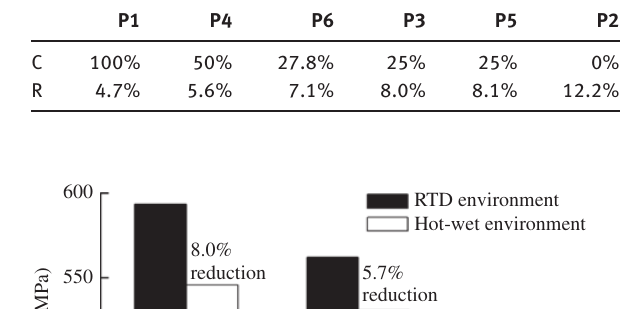
Figure 4: Tensile strength of the specimens with Z-pins. (A) Tensile strength of the unidirectional tape specimens with Z-pins. (B) Tensile strength of the woven cloth specimens with Z-pins.